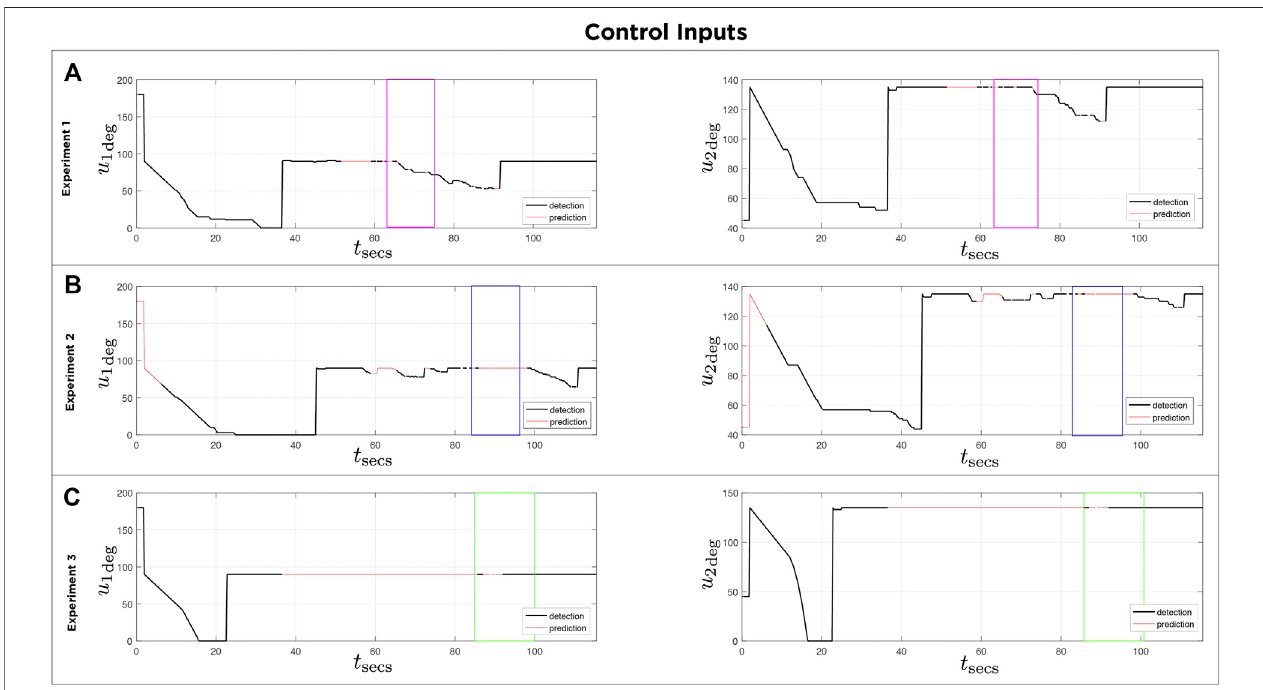
FIGURE13| Foreachofthethreeexperiments (A , B , C) :Referencesignals u 1 and u 2 calculatedusingproposedcontrollaw.Blacklinesindicatetimeintervalswhen target was detected. Red lines indicate time intervals when controller used the Kalman fi lter prediction.